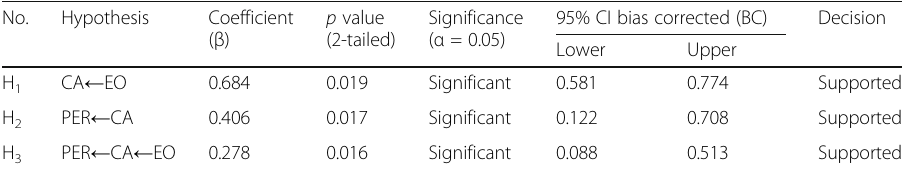
Table 4 Direct and indirect effects for personal wealth measures